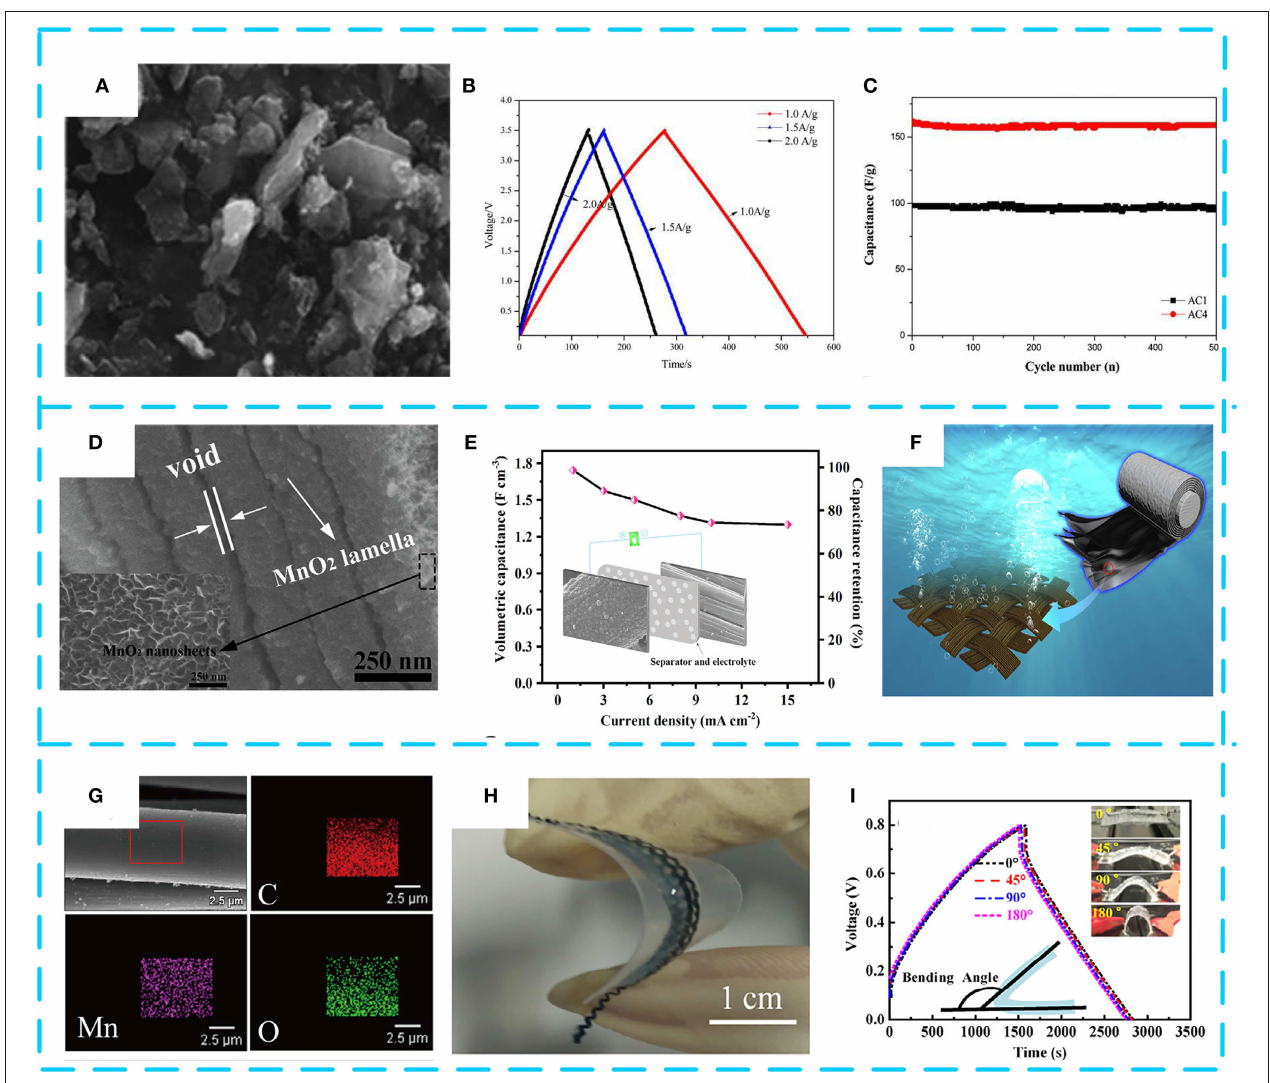
FIGURE 6 | (A) Scanning electron microscopy (SEM) images of AC4. (B) Galvanostatic charge/discharge curves of AC4 at 1.0A g − 1 . (C) Charge–discharge cycling stability of AC4 at current density of 2A g − 1 . Reproduced from Chen M. D. et al. (2014) with permission from Maney Publishing. (D) Cross-sectional SEM image of MnO 2 /AC cloth-300. (E) Variations of the capacitance with current densities. (F) Schematic representation of the as-prepared electrode. Reproduced from (Zhang J. et al., 2019) with permission from Elsevier BV. (G) The corresponding energy-dispersive X-ray spectroscopy (EDS) elemental maps of Mn, O, and C. (H) Structure and electrochemical performance. (I) Charge–discharge curves at 0.1mA cm − 2 under different bending states of the MnO 2 @ACF-6. Reproduced from (Li H. et al., 2019) with permission from